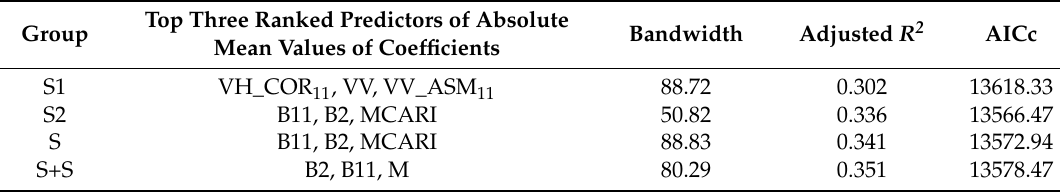
Table 5. Summary of AGB models by GWR.